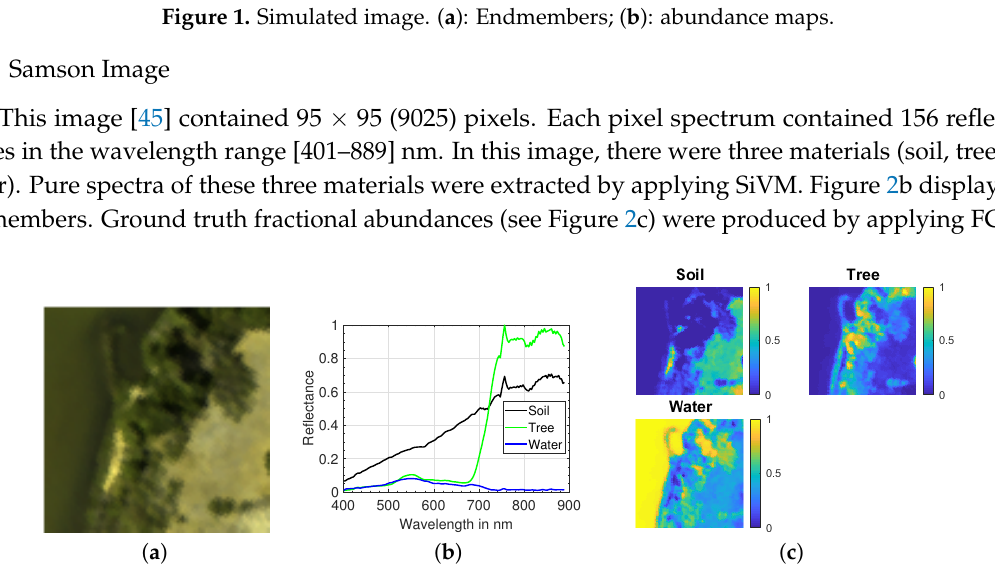
Figure 2. Samson image. ( a ): True-color image (red: 571.01 nm, green: 539.53 nm, blue: 432.48 nm); ( b ): endmembers; ( c ): abundance maps.